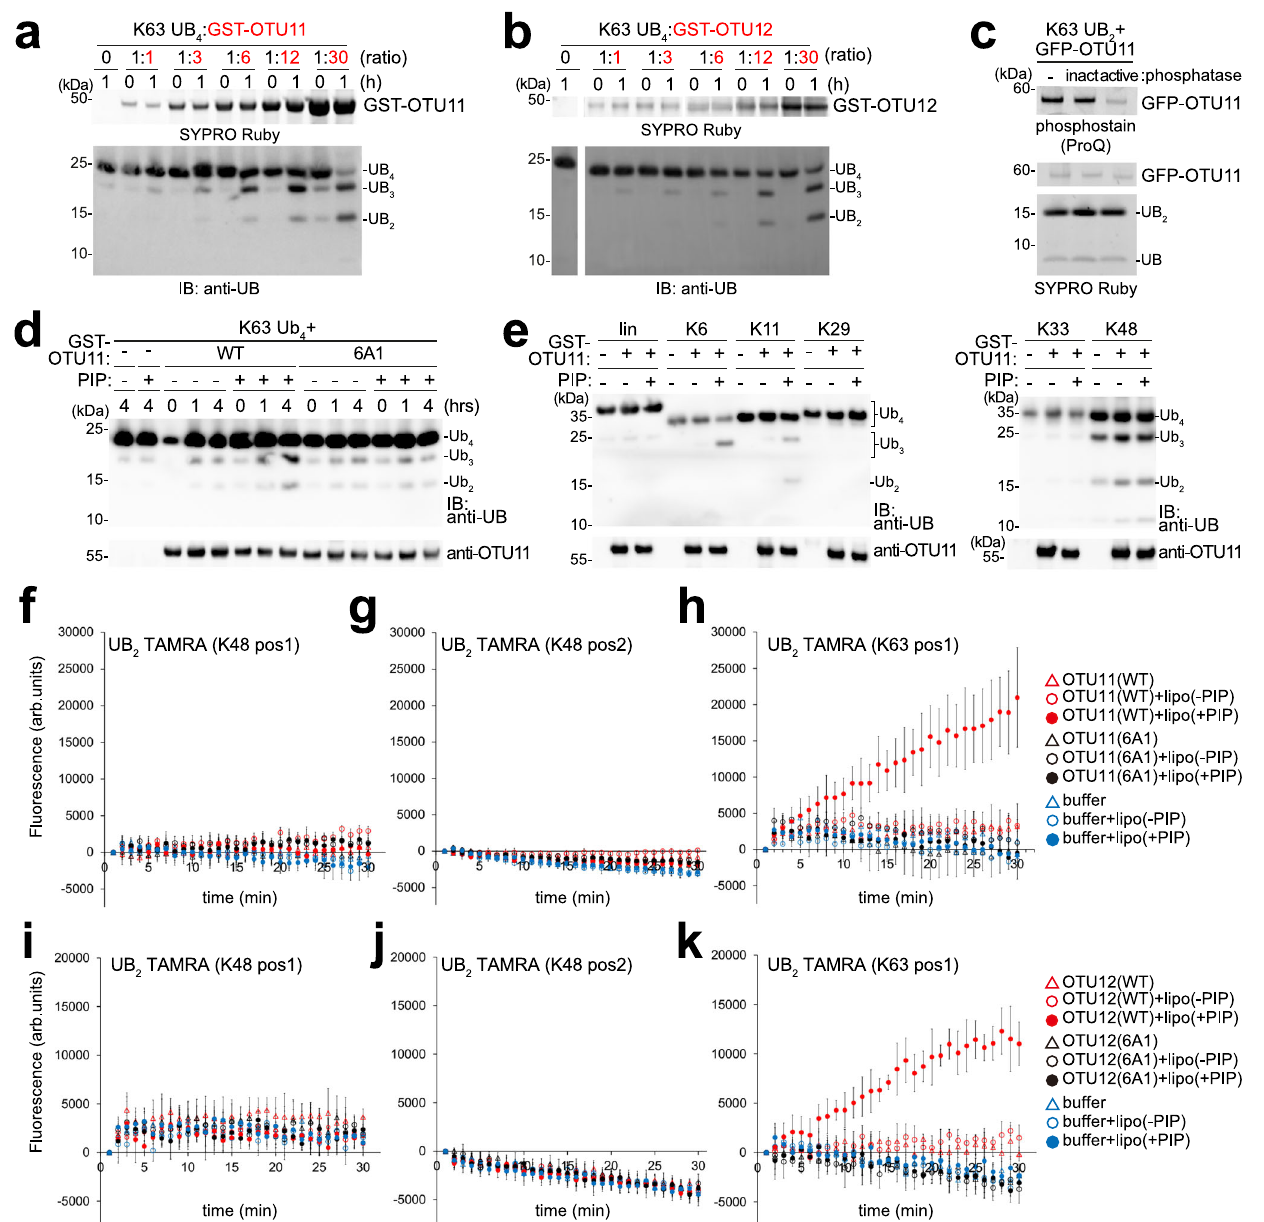
Fig. 8 | The in vitro DUB activity of OTU11 and OTU12 is stimulated by anionic lipids. a , b DUB assays with GST-OTU11 ( a ) and GST-OTU12 ( b ). 7.5 pmol of K63- linked tetra-UB was incubated with 7.5pmol (substrate: enzyme ratio 1:1), 25pmol (1:3),50pmol(1:6),100pmol(1:12),or250pmol(1:30)ofGST-OTU11orGST-OTU12 for 1h at 21°C. The experiments were repeated at least three times, and one representative image is shown. c DUB assay with phosphatase treated GFP-OTU11 puri fi ed from 35Spro: GFP-OTU11 expressing Arabidopsis seedlings and 15pmol of K63-linked di-UB. active: active phosphatase, inact: heat-inactivated phosphatase. The experiment was repeated at least three times; one representative image is shown. d , e DUB assays with GST-OTU11 (WT) and GST-OTU11(6A1) pre-incubated with liposomes generated with PC and PE (PC/PE) alone ( − PIP) or with liposomes (PC/PE) containing 5% PI(4,5)P 2 (+PIP). In ( d ), 25pmol of GST-OTU11(WT) or GST- OTU11(6A1) wasincubated for the indicated time with 25pmol of K63-linked tetra-